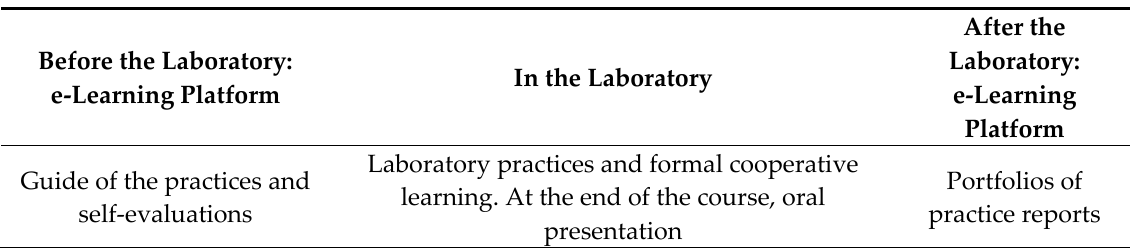
Table 2. Methodologies of laboratory